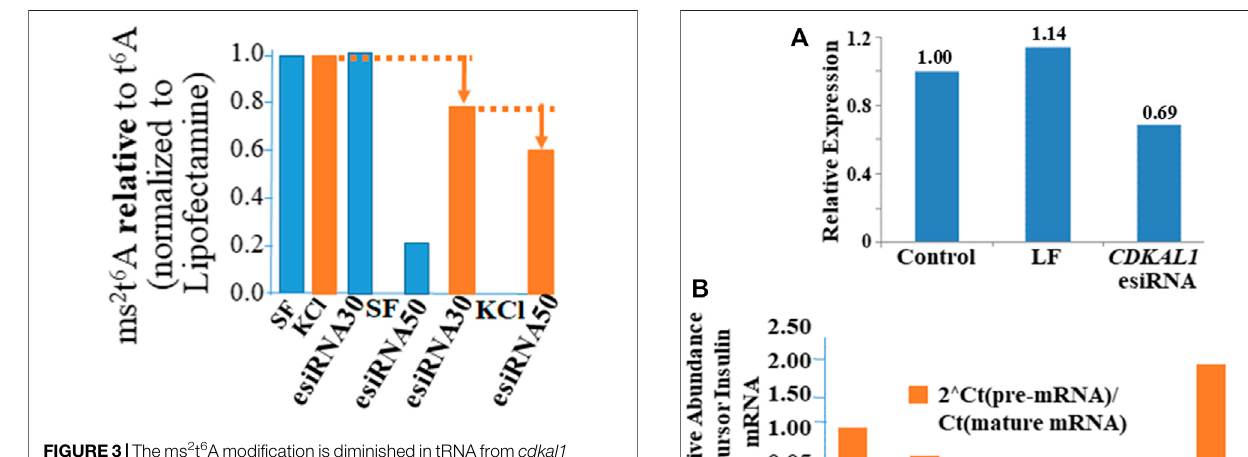
FIGURE3| The ms 2 t 6 Amodi fi cationisdiminished in tRNAfrom cdkal1 esiRNA knockdown cells. The modi fi ed nucleosides in small RNA puri fi ed from esiRNA30 and esiRNA50 knockdown cells and control LF cells were hydrolyzed to nucleosides and analyzed by UHPLC-MS/MS. The results are presented as the amount of ms 2 t 6 A relative to ms 2 t 6 A plus t 6 A (ms 2 t 6 A/ms 2 t 6 A + t 6 A) normalized to LF controls. Initially the concentrations of ms 2 t 6 A and t 6 A were determined relative to the major nucleoside A. The resultsaretheaverageofthreebiologicalassaysconductedbytwodifferent institutions. LF — control cells transfected with Lipofectamine only; esiRNA30and50 — Cdkal1knockdowncellstransfectedwith30and50 nM esiRNA. SF — control cells serum-free; KCl — 4 mM KCl